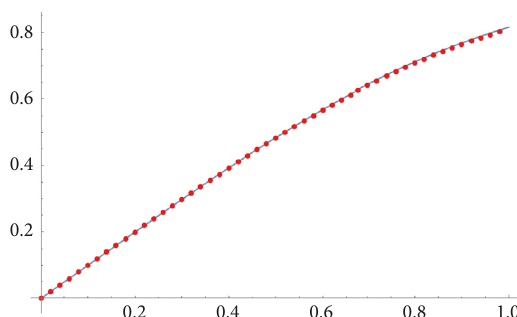
𝑥 𝑒 −𝑧 2 /2 d 𝑧. It is CDF −∞